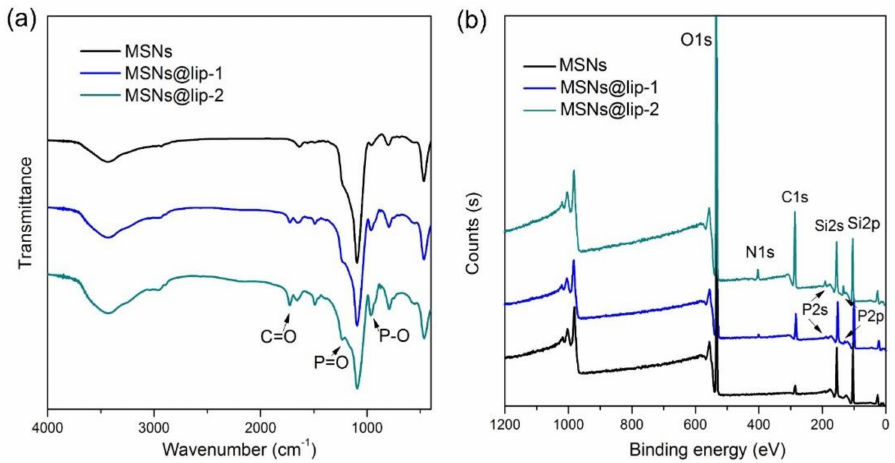
Figure 2. Composition characterization of MSNs, MSNs@lip-1 and MSNs@lip-2: ( a ) FTIR spectra show